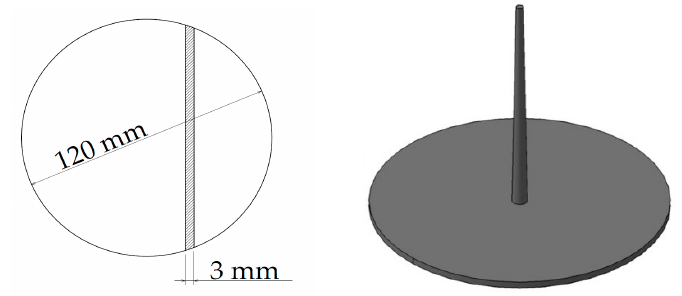
Figure 3. Disc specimen geometry with a thickness of 3 mm and a diameter of 120 mm.